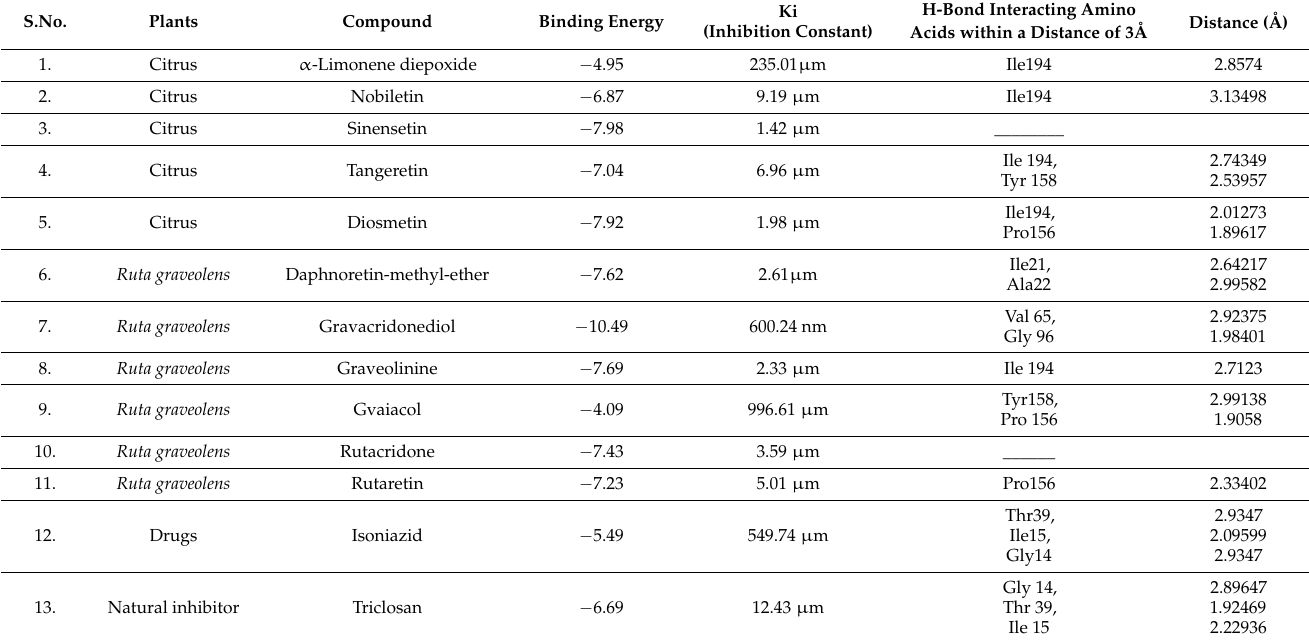
Table 3. Binding energy of docked protein InhA and ligands, along with that of the natural in- hibitor